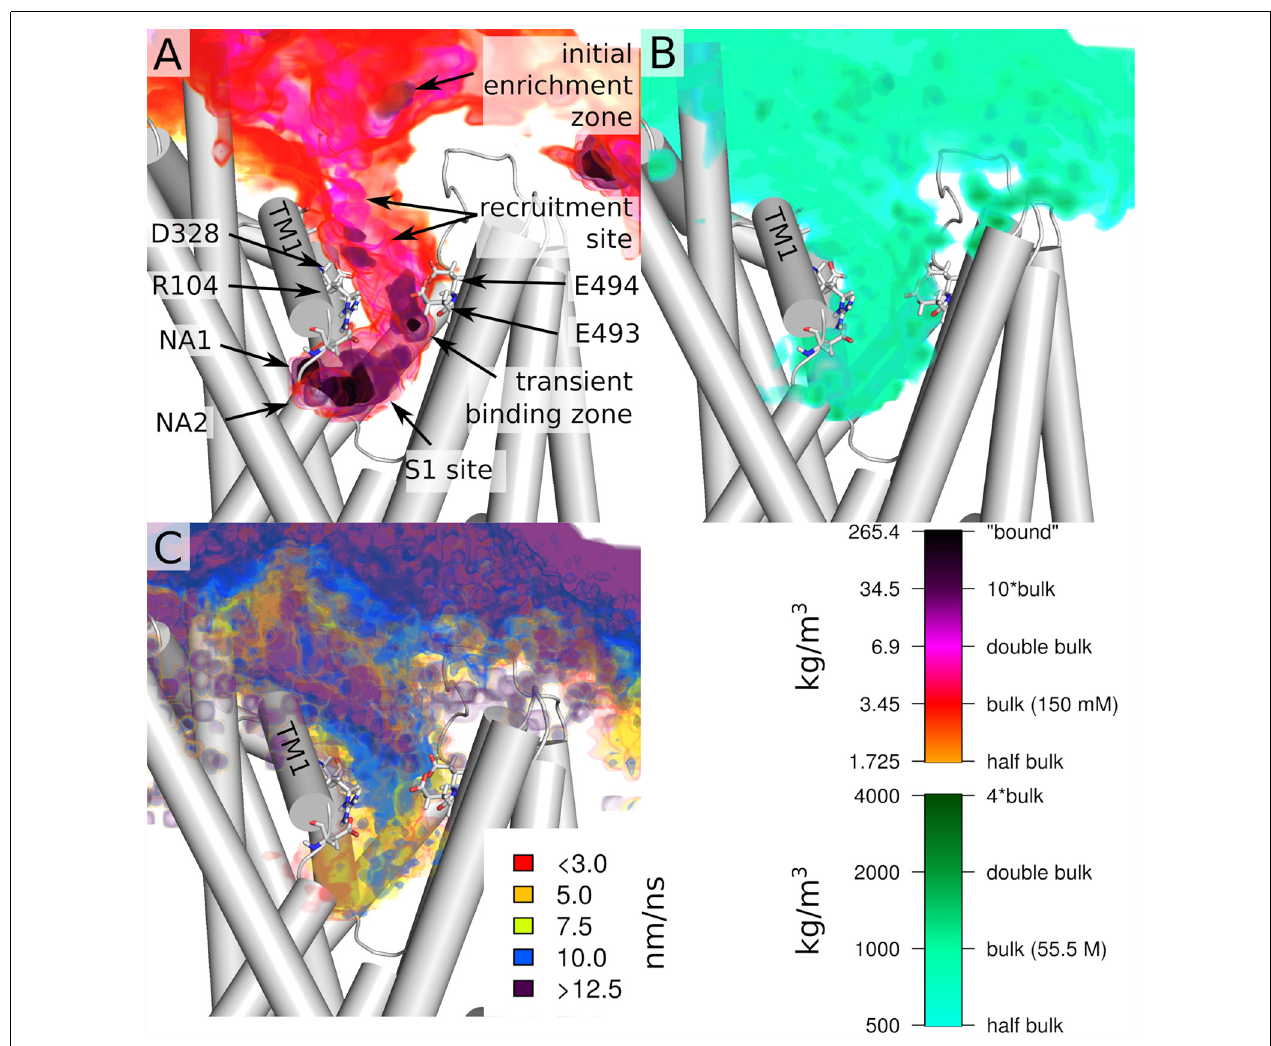
FIGURE 3 | Overview of the entry path of sodium ions. (A) Spatial density of sodium ion and (B) water at the protein extracellular interface and in the outer vestibule. (C) Velocity of sodium ion movements (displacement) at the extracellular interface and in the outer vestibule. All values are shown as colored volumes together with the starting structure of the first replica. Values are averages of all 51 trajectories, which were initially fitted by their C α atoms. Trajectories were analyzed every 5 ps for the spatial densities and every 10 ps for displacement. The spatial grids have a resolution of 0.1